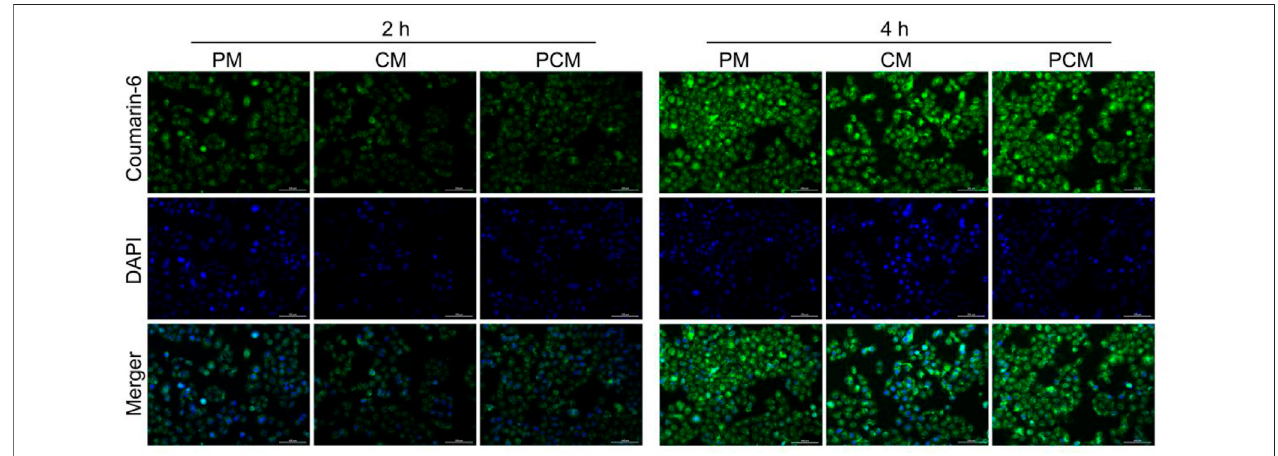
FIGURE 3 | Fluorescence microscope images of BGC-823 cells after incubation with coumarin-6-loaded PM, CM, and PCM2 micelles for 2 or 4 h, respectively.